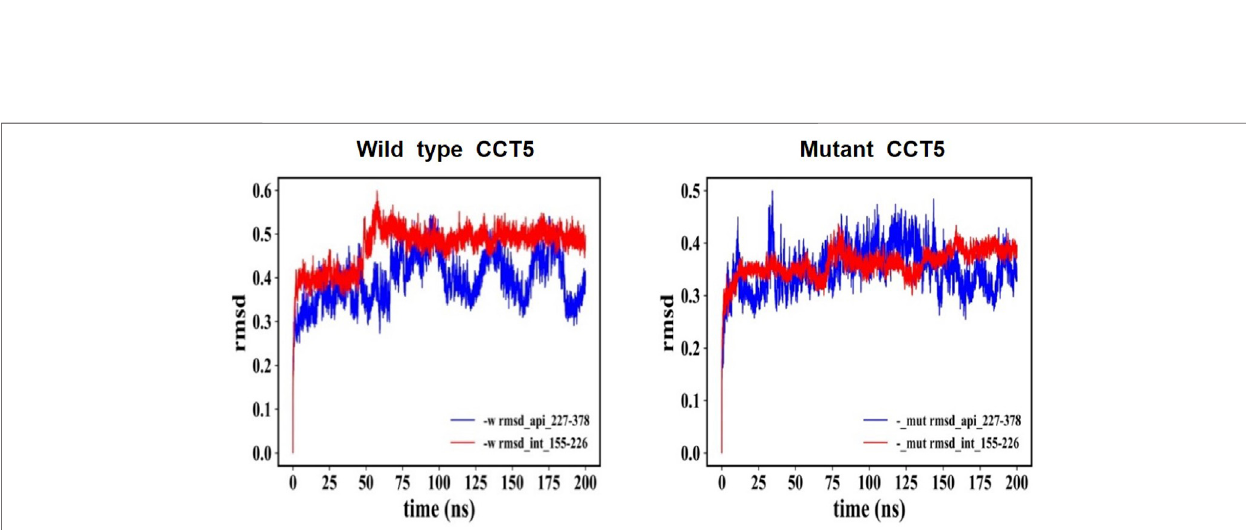
Frontiers in Molecular Biosciences |